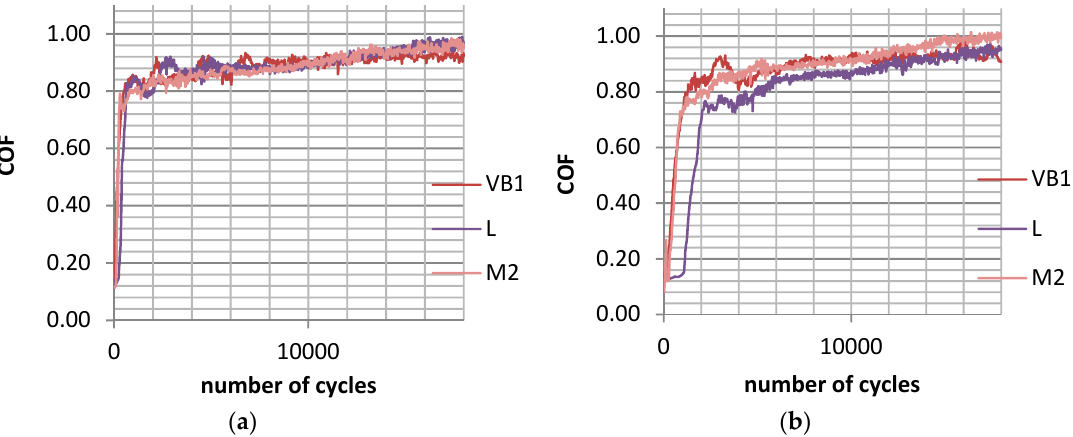
Figure 2. Maximum coefficient of friction during test A; s = 0.2 mm, P = 45 N, f = 20 Hz ( a ) and during test B; s = 0.15 mm, P = 45 N, f = 20 Hz ( b ) for selected assemblies with discs: after vapour blasting VB1, after lapping L and after milling M2.